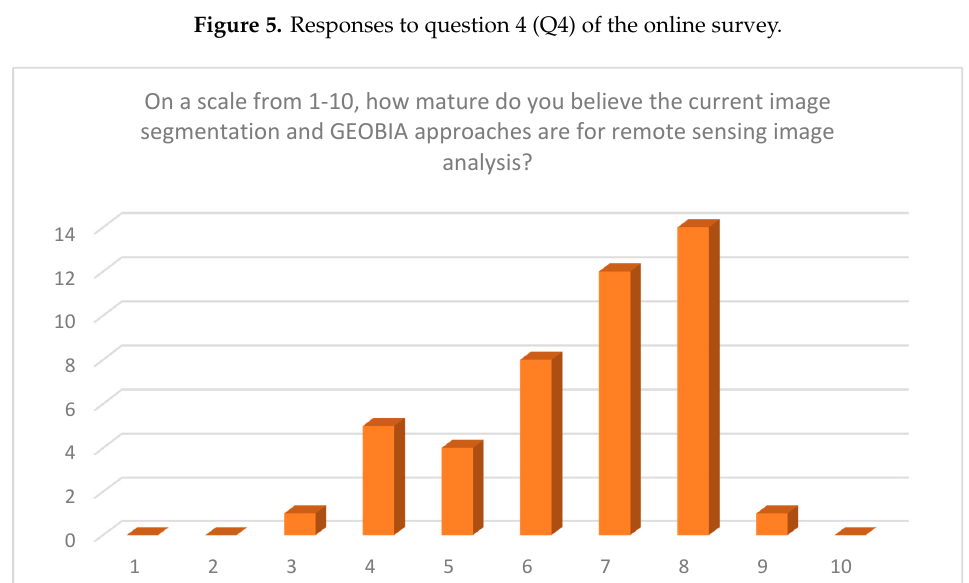
Figure 6. Responses to question 5 (Q5) of the survey. Values range from 1-10, with a value of 1 indicating a respondent perceived that “They are still at a very early stage of development”, and a value of 10 indicating the respondent perceived that “They are already good enough, and little-to-no further improvements are required”.